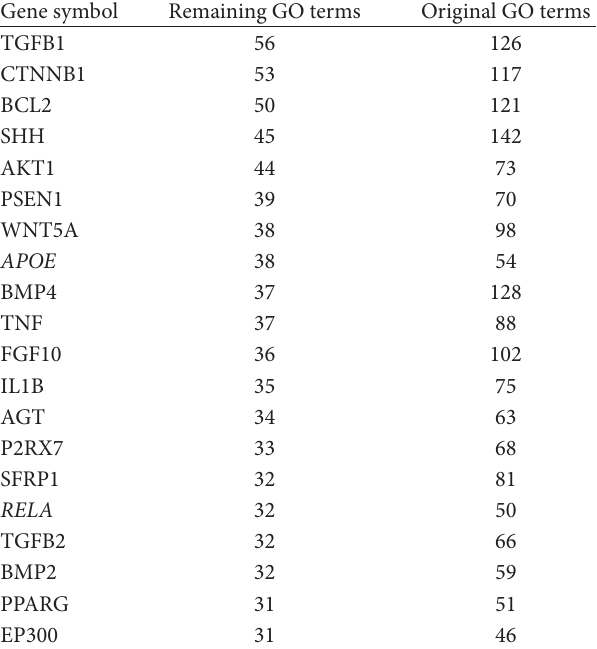
T 10: GOrevenge prioritization. e second column refers to the number of GO terms remaining aer GOrevenge pruning, re�ecting the centrality of each gene, while the third column refers to the original number of biological process category GO terms of each gene. Top 20 genes are shown. Genes presented in italics are among the statistically signi�cant differentiated genes in at least two of either SZ or BD DE gene